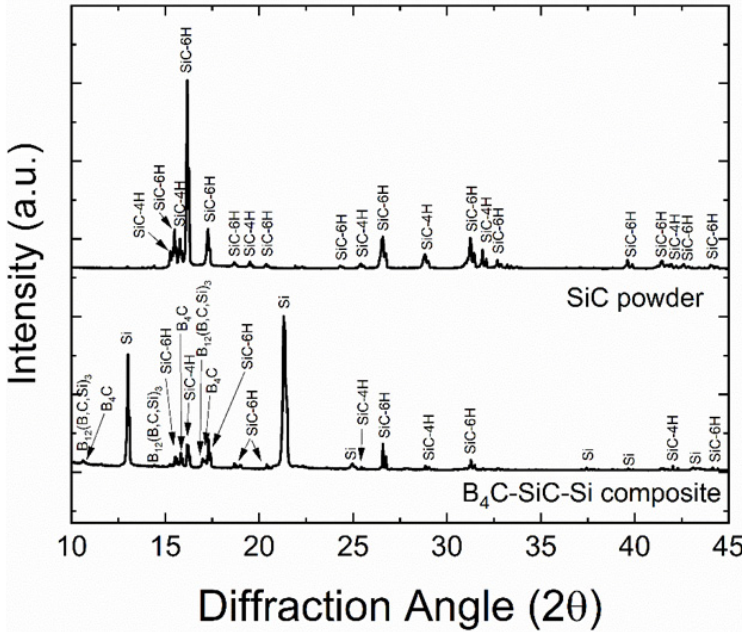
Figure 3. XRD patterns of the SiC powder and SiC-B 4 C-Si composite.